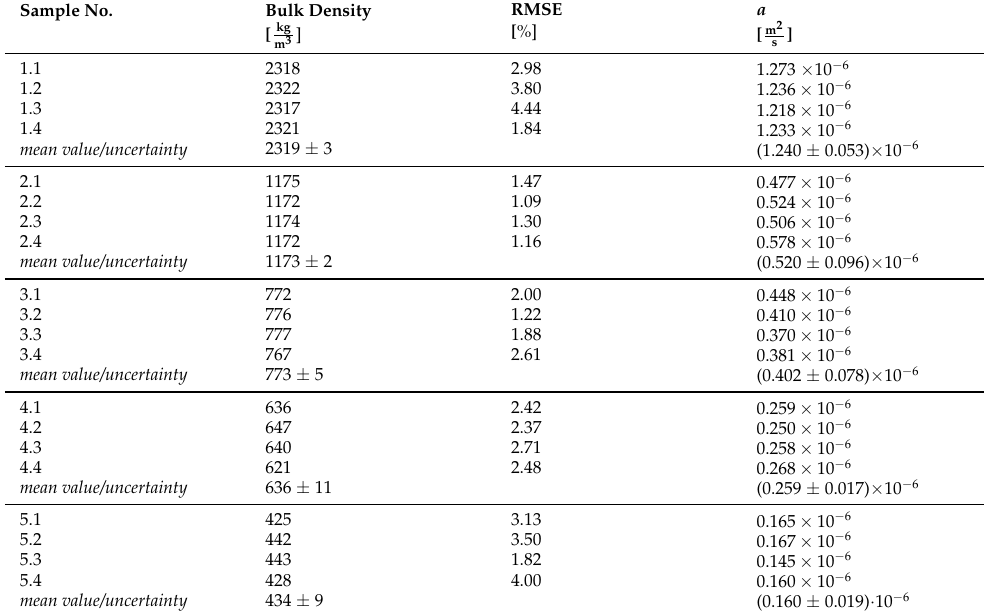
Table 1. Summary of values for the thermal diffusivity coefficient calculated using the back- calculation